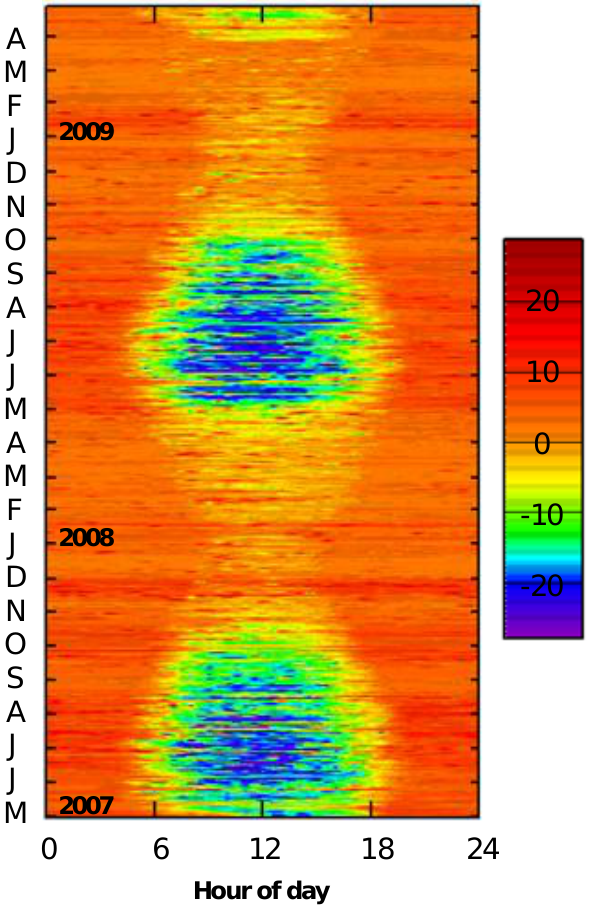
Fig. 5. The net ecosystem exchange (NEE) “fingerprint” of Wytham Woods showing diurnal (x-axis) and seasonal (y-axis) CO 2 fluxes in µmolsCO 2 m − 2 s − 1 , generated using CarboEurope’s online par- titioning tool.